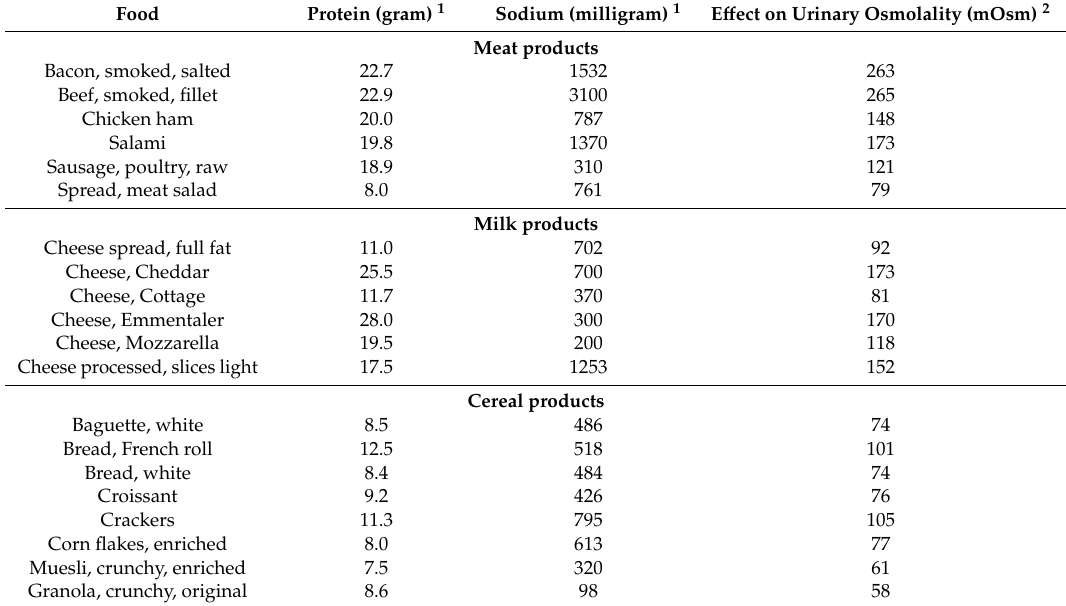
Table 3. Commonly eaten protein-rich foods with their sodium content and their estimated e ff ect on urinary osmolality by urea and sodium, per 100 g of edible